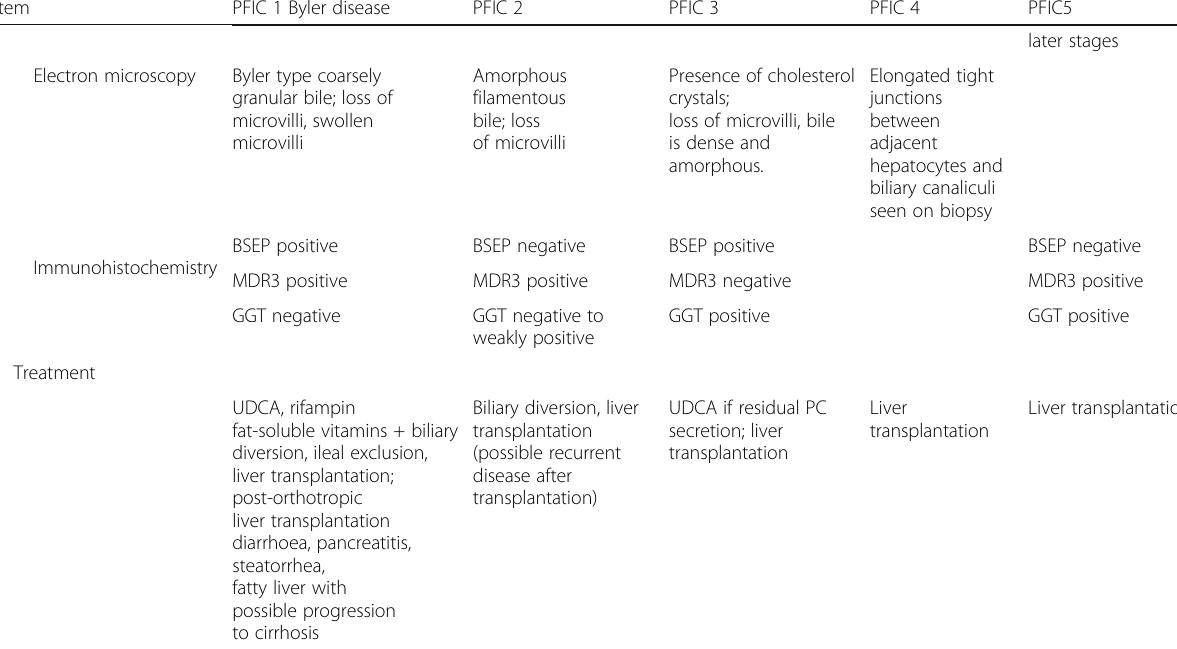
Table 1 Characteristic features of the different types of progressive familial intrahepatic cholestasis [102 – 104] (Continued)